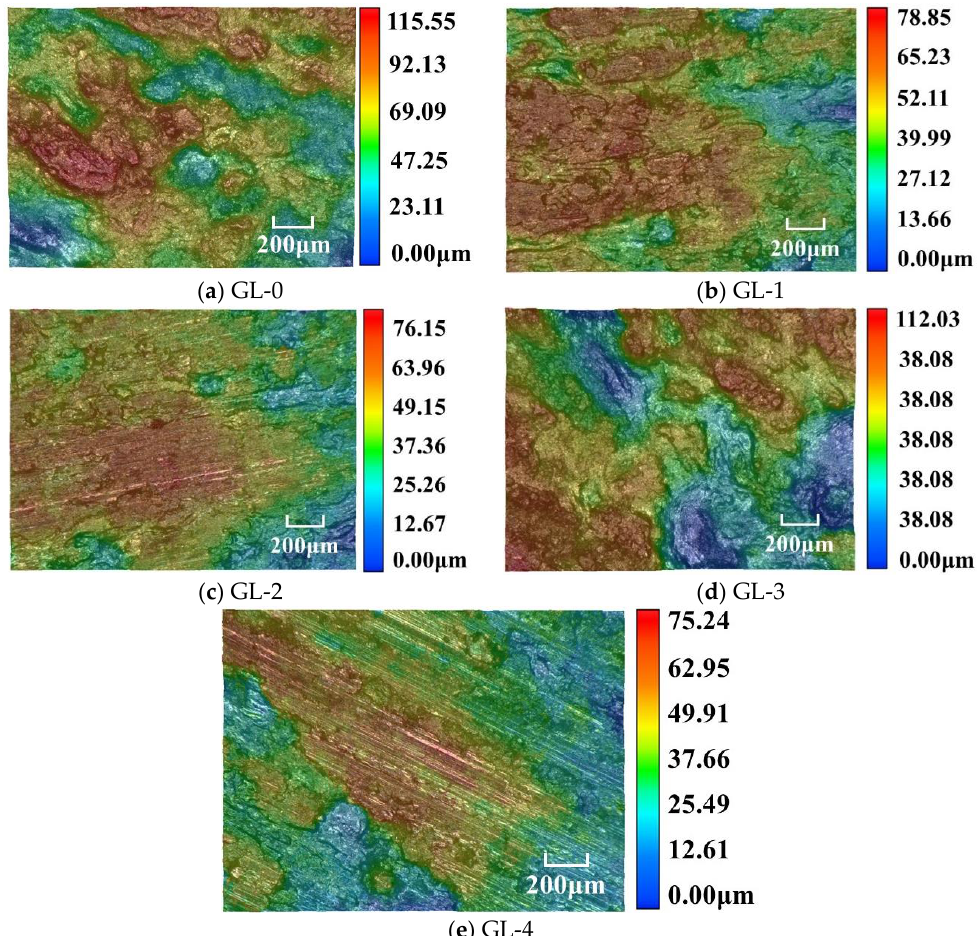
Figure 7. Three-Dimensional Microscope of worn surface.